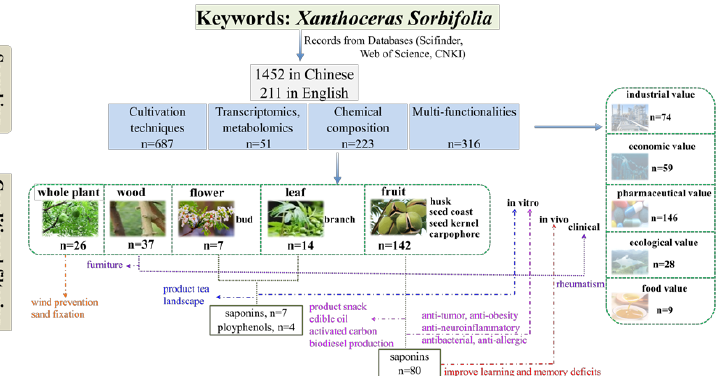
Figure 1. Flow diagram showing the search strategy, the number of records identified, and the main compositions and uses in different parts of X. sorbifolia .